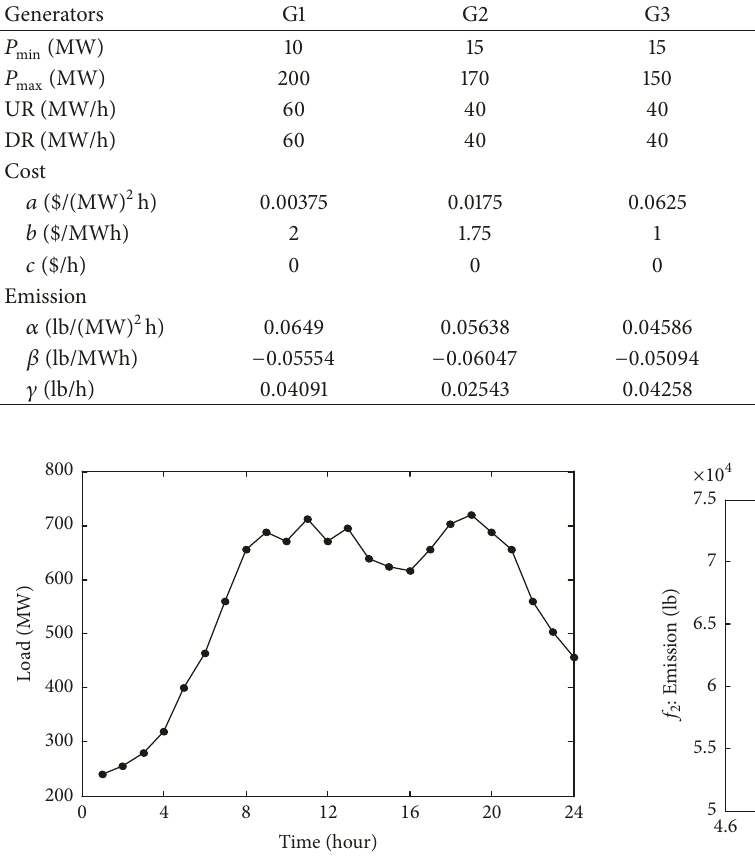
Figure 3: Predicted load demand for the 24 hours, next day.